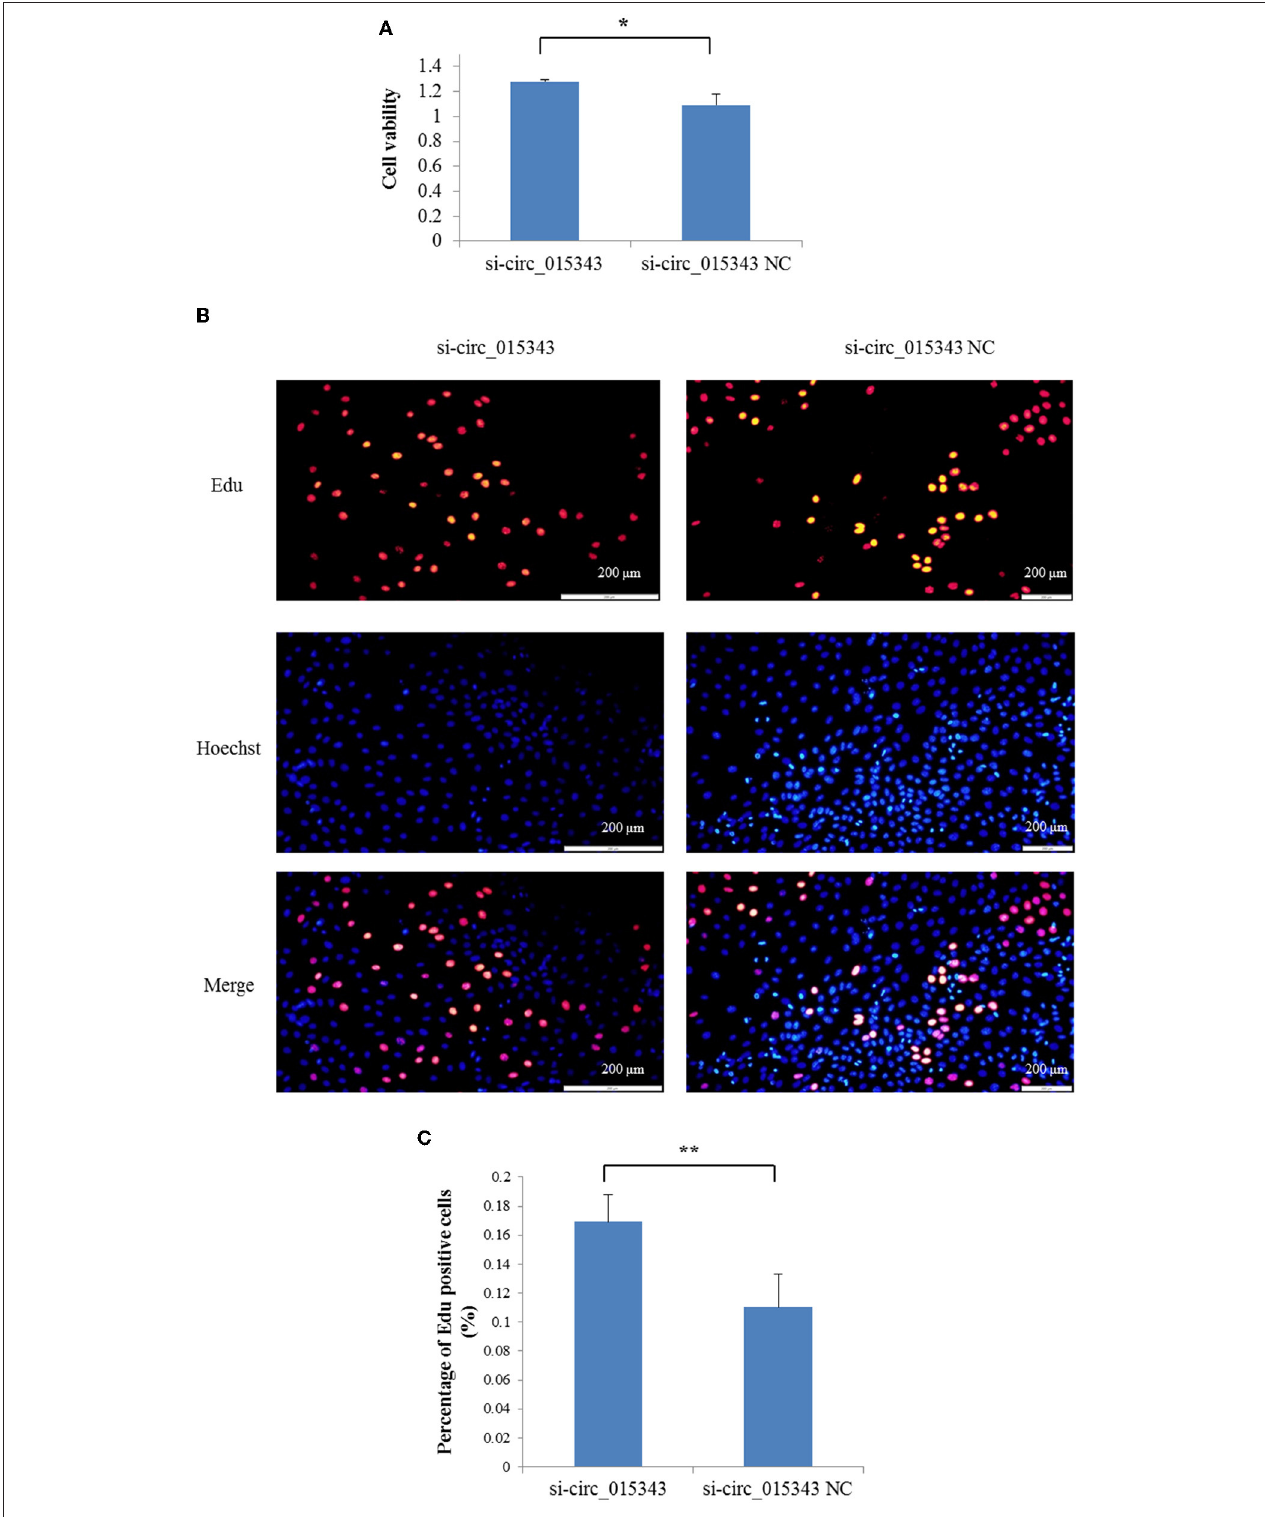
FIGURE 7 | The effect of circ_015343 on the viability and proliferation of ovine mammary epithelial cells. (A) The viability of ovine mammary epithelial cells detected by using CCK8 assay when si-circ_015343 was transfected into ovine mammary epithelial cells. (B) The effect of circ_015343 on the proliferation of ovine mammary epithelial cells was detected by using Edu assay. (C) The proportion of Edu-labeled positive mammary epithelial cells in ovine total mammary epithelial cells. ** p < 0.01.